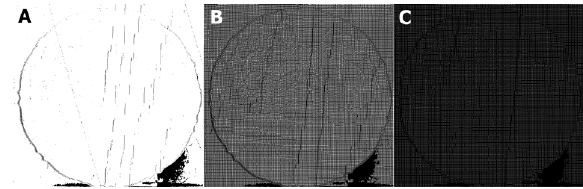
Fig ure 10. Point clouds of the test object, colour by classification acquire from a 5 m distance, with resolution 1/1 (A), 1/2 (B) and 1/4 (C)